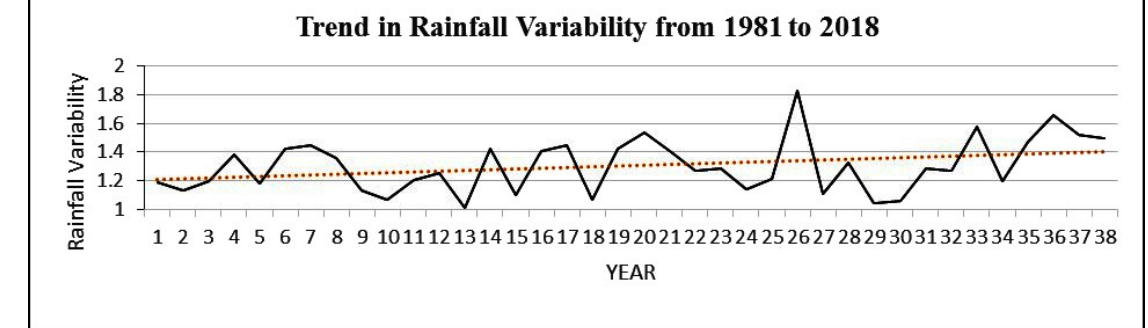
Figure 2. Trend in rainfall variability from 1981 to 2018.